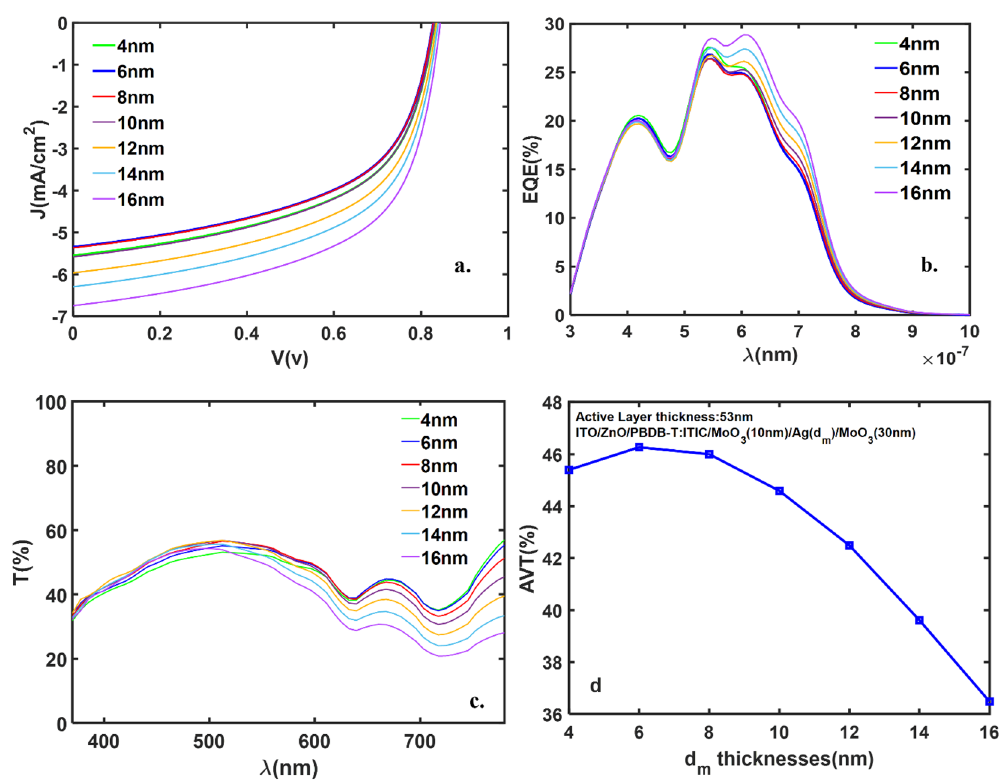
Figure 5. ( a ) The J-V curve, ( b ) the EQE as a function of wavelength, ( c ) T as a function of the wavelength, ( d ) the AVT as a function of d m thicknesses for the devices with the active layer thickness of 53